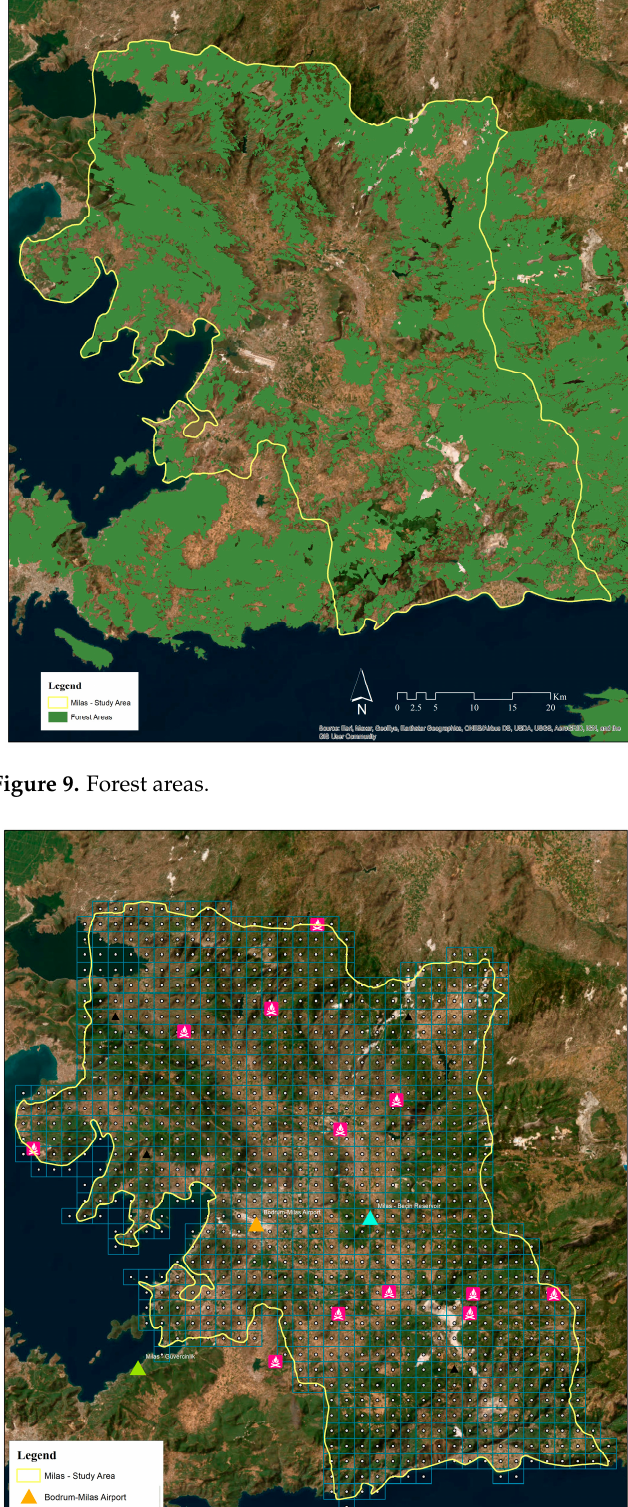
Figure 8. ( a ) Regular grid distribution; ( b ) irregular grid distribution.